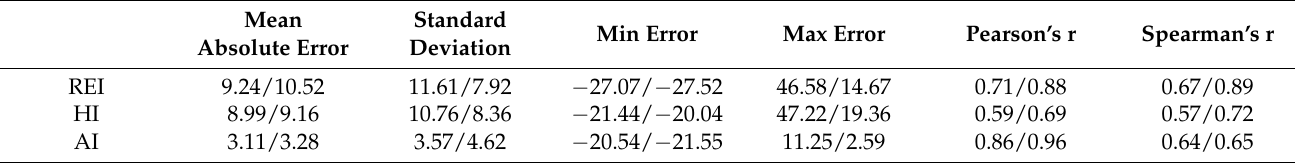
Table 5. Mean error, standard deviation, min and max errors, Pearson’s and Spearman’s correlation coefficients for REI, HI and AI. The values were averaged across five experiment iterations. Data obtained on SHHS-1/PhysioNet databases.